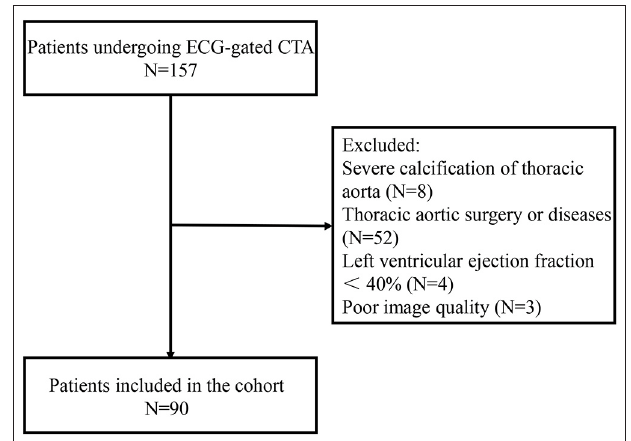
FIGURE 1 | Flowchart of inclusion of